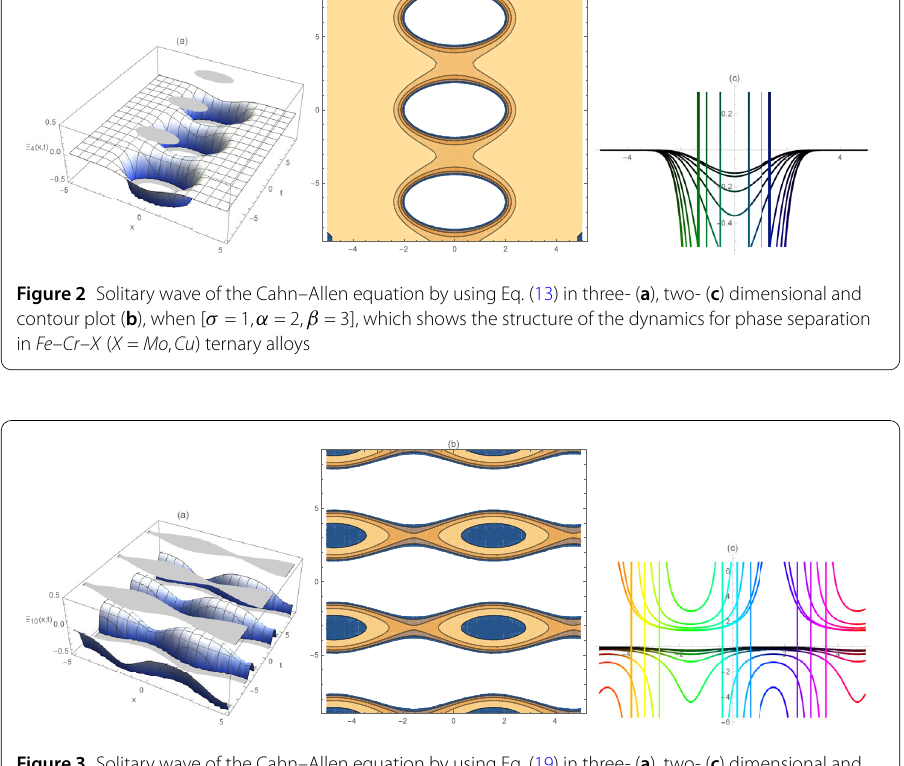
Figure 3 Solitary wave of the Cahn–Allen equation by using Eq. (19) in three- ( a ), two- ( c ) dimensional and contour plot ( b ), when [ σ = 1, α = 0, β = 3], which shows the structure of the dynamics for phase separation in Fe – Cr – X ( X = Mo , Cu ) ternary alloys